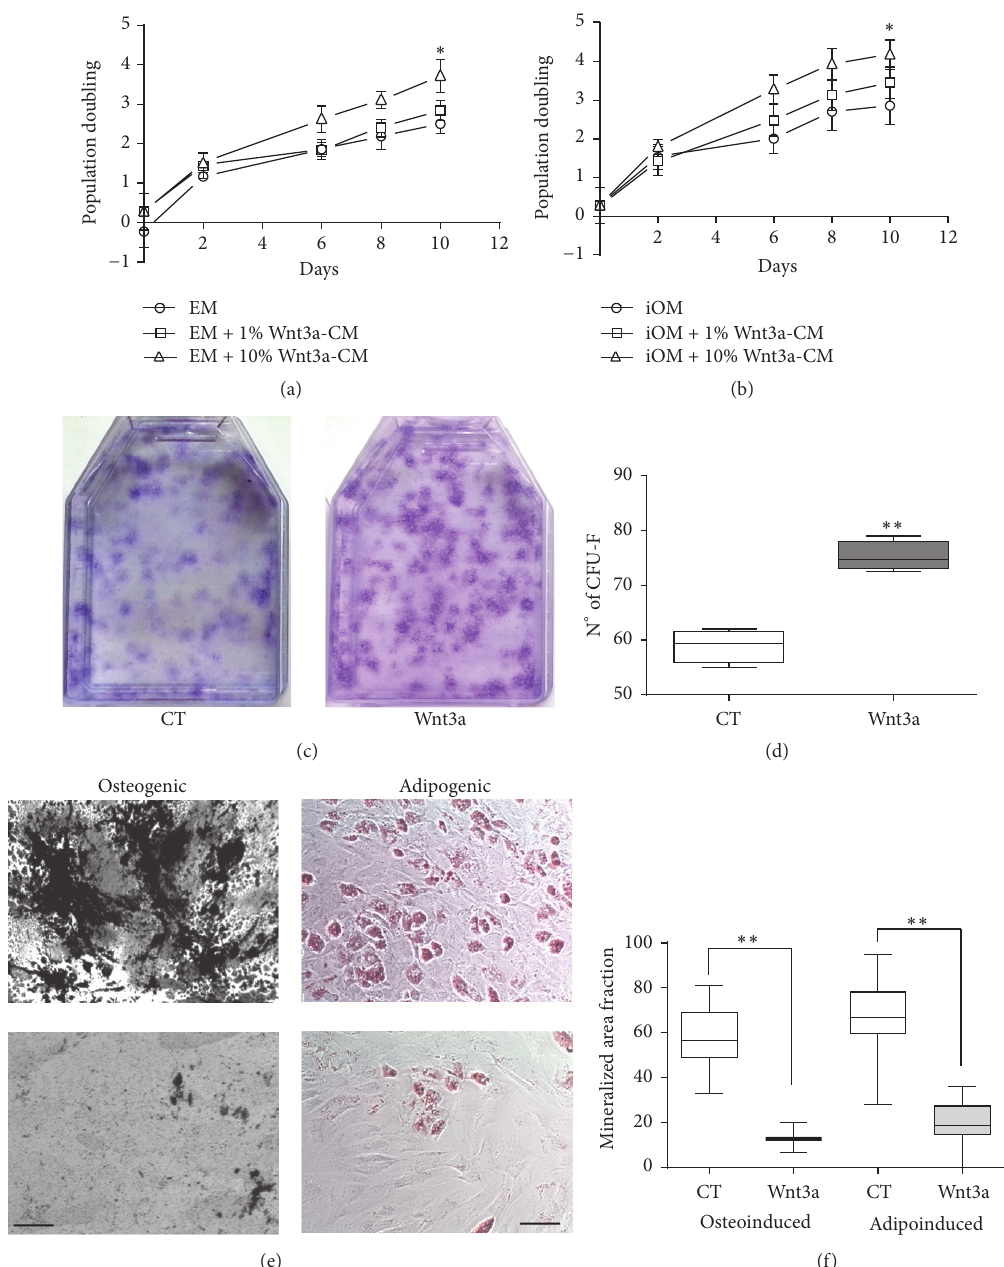
Figure 2: Wnt3a-CM stimulates proliferation and impairs BMSCs differentiation. (a-b) Cumulative population doublings of BMSCs cultured with either expansion medium (EM (a)) or incomplete osteogenic medium (iOM, without dexamethasone (b)) supplemented with 1% or 10% Wnt3a-CM. Data represent mean ± SD of 3 independent experiments with triplicates. (c-d) BMSCs expanded in the presence of 10% Wnt3a-CM for 10 days were plated at clonal density and maintained in control expansion medium for another 14 days. Morphology (c) and quantification (d) of CFU-F formed by control (CT) and Wnt3a-expanded BMSCs are shown. Data represent mean ± SD of 4 experiments with quadruplicates. (e) Representative micrographs of control and Wnt3a-expanded BMSCs induced towards the osteogenic (left panel) and adipogenic lineages (right panel) stained with Von Kossa and Oil Red O, respectively. Bars = 100 𝜇 m. (f) Quantification of total mineralized area and fat accumulating cells per field of view. Data represent mean ± SD of 4 experiments with triplicates. ∗ 𝑝 < 0.05 ; ∗∗ 𝑝 < 0.001